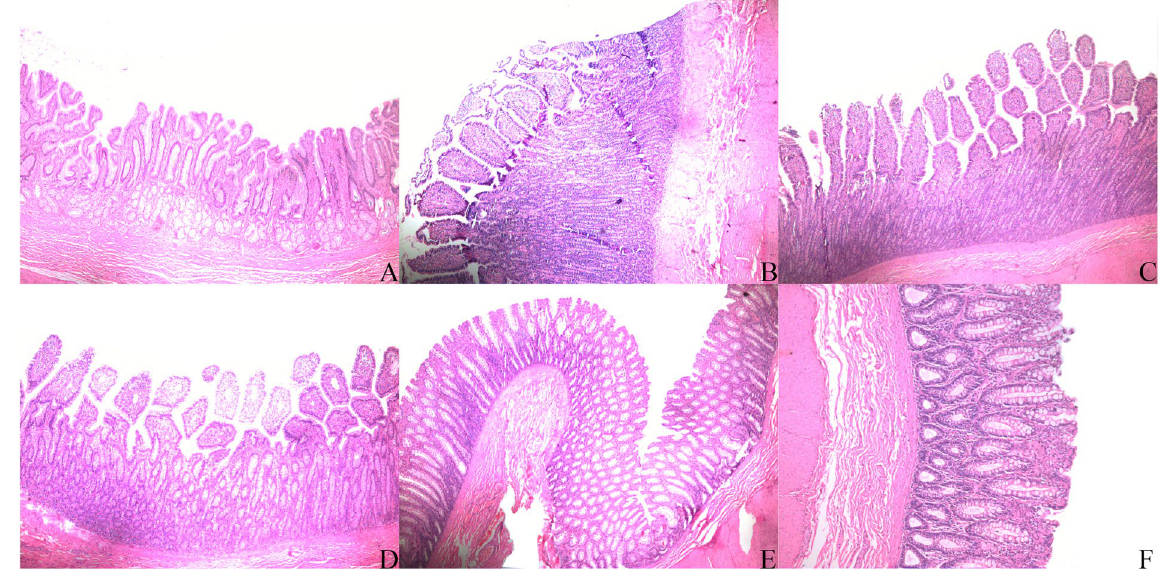
Figure 2. Pathological sections of integrated gastrointestinal wall after capsule administration. None reported lesion or abnormality. ( A ) Stomach. ( B ) Duodenum. ( C ) Jejunum. ( D ) Ileum. ( E , F )